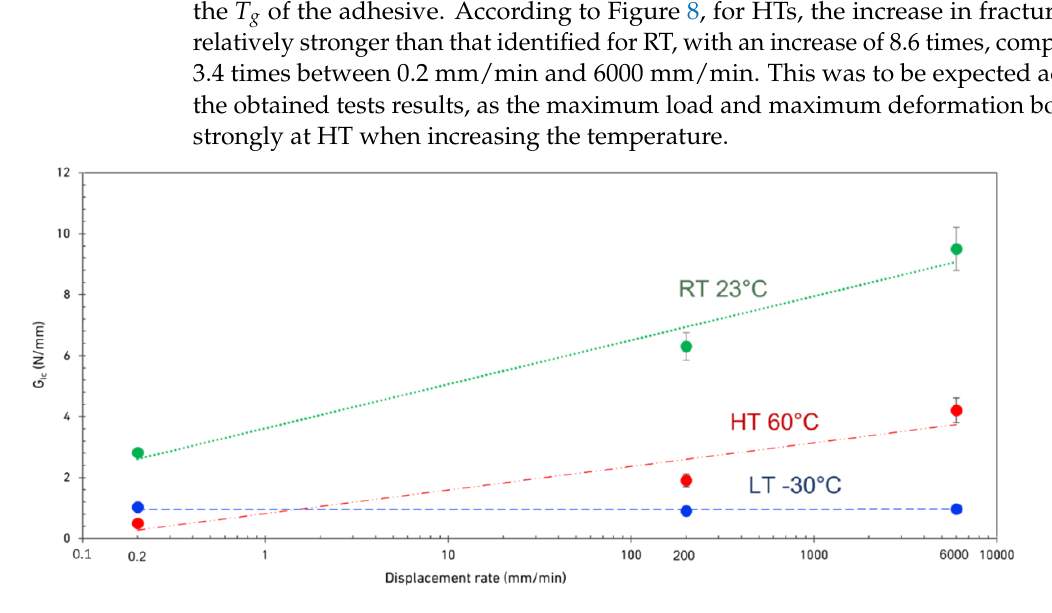
Figure 8. Mode I fracture energy as a function of displacement rate for different temperatures.